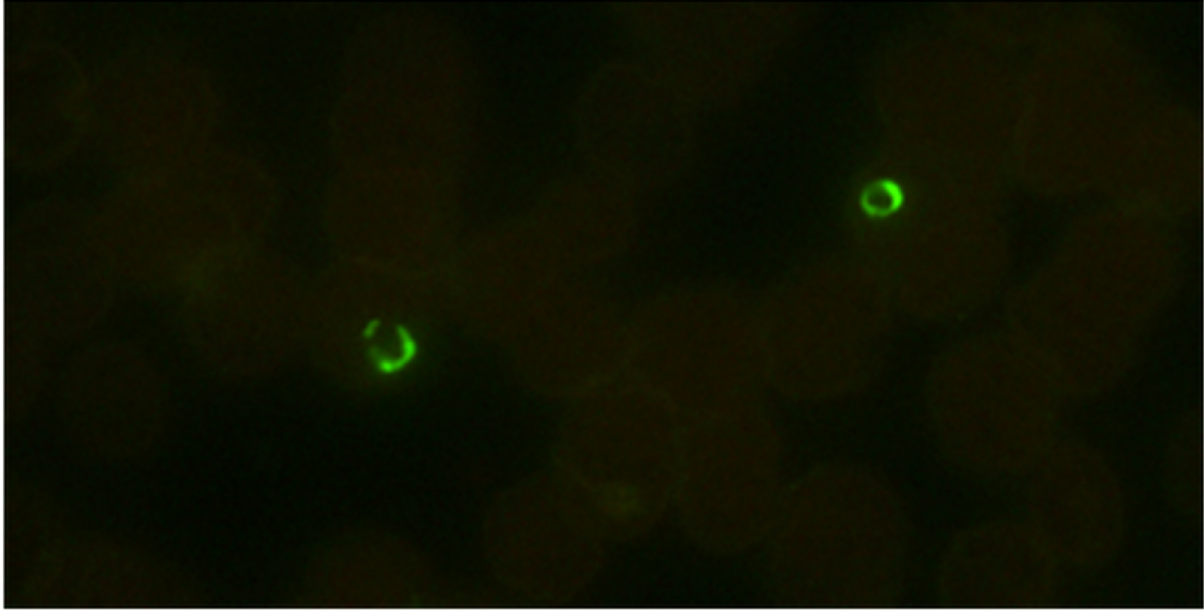
Fig 5. P . falciparum positive patient ’ s finger-prick capillary blood smear tested with Plasmodium genus FISH assay. Smear prepared from finger- prick capillary blood without anticoagulant. Green fluorescence indicates the presence of Plasmodium ribosomal RNA (rRNA) due to reaction with Plasmodium genus